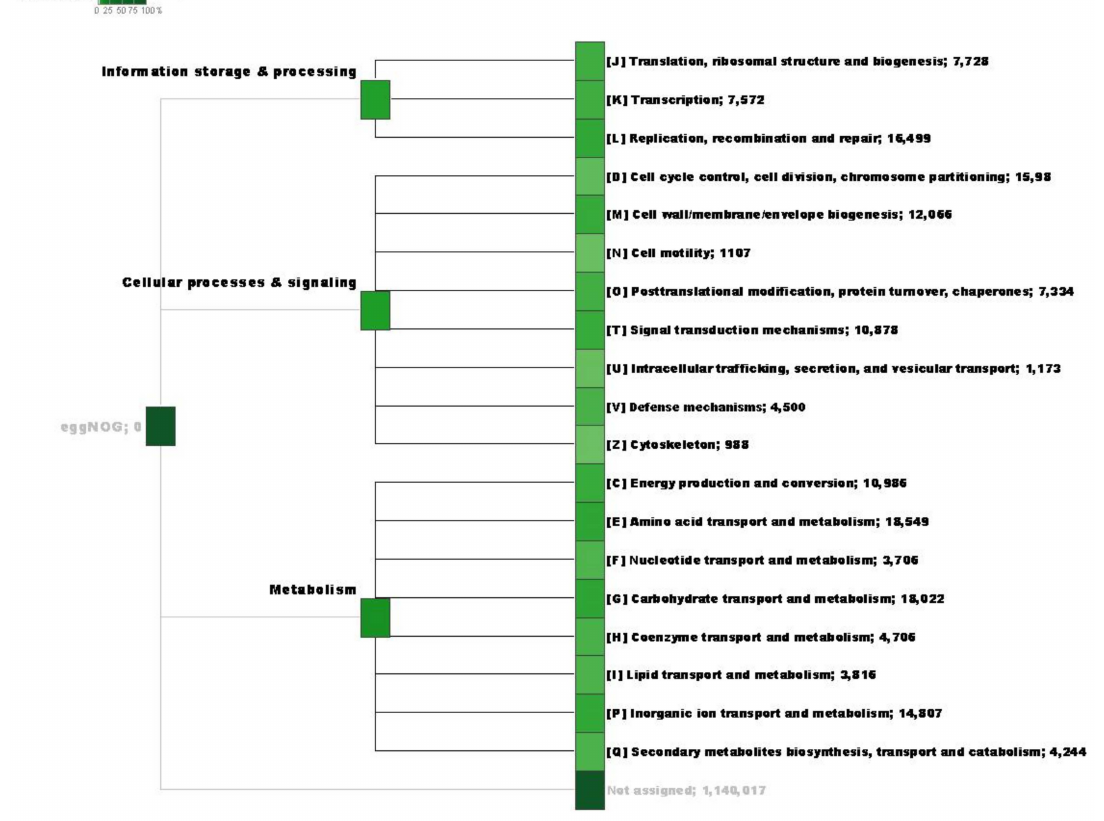
Figure 5. Functional domain analysis showing the major functional domains contributing to growth and